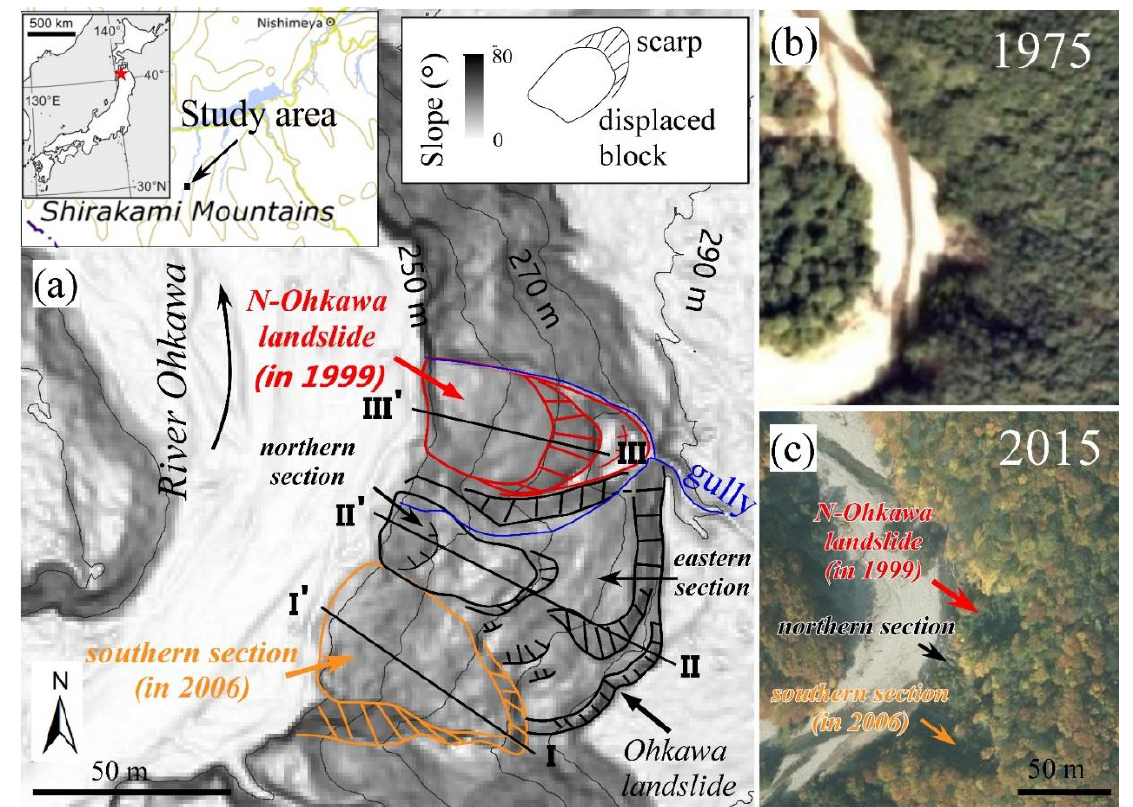
Figure 1. Coherent landslides, topographic map, and aerial photographs from the study area. ( a ) Landslide topography. Aerial photographs are from ( b ) 1975 and ( c ) 2015. The topographic map was constructed from a 1-m digital elevation model (DEM) based on LiDAR data provided by the Geospatial Information Authority of Japan (https://www.gsi.go.jp/, accessed on 12 April 2020). The landslide topography was interpreted using the slope image and the results were checked in the field. Topographic cross-sections (I–I’, II–II’, and III–III’) are shown in Figure 2.